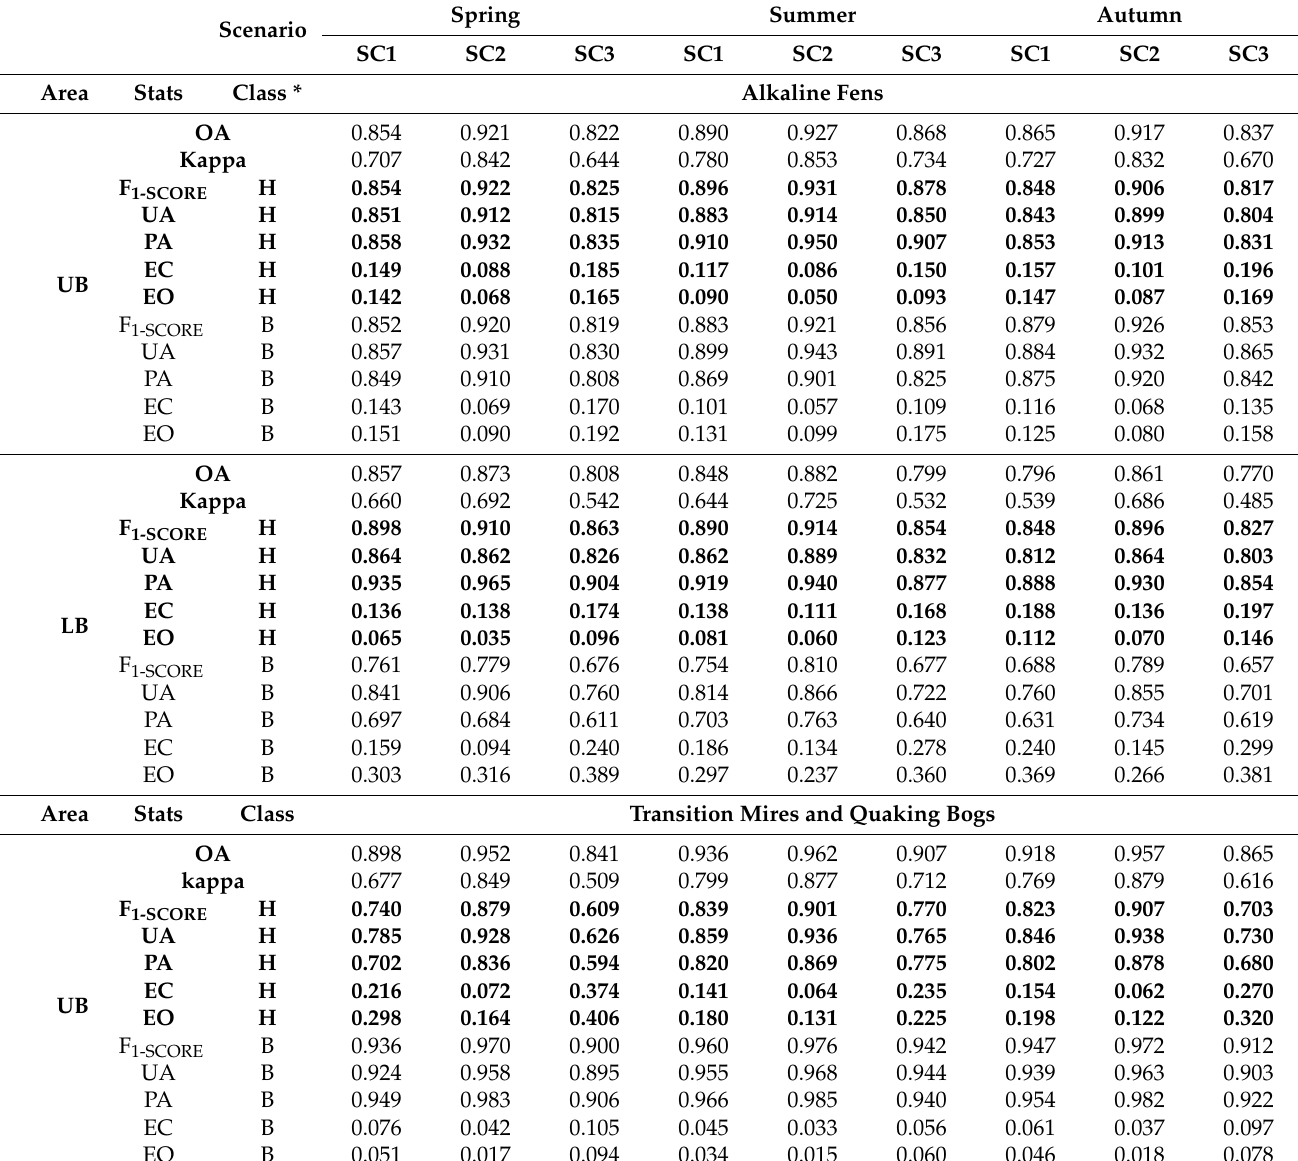
Table 3. Results of multi-classification (50 classifications per scenario) on randomly selected botanical reference data for wetland habitats in the UB, LB, and JF areas in scenarios from 1 to